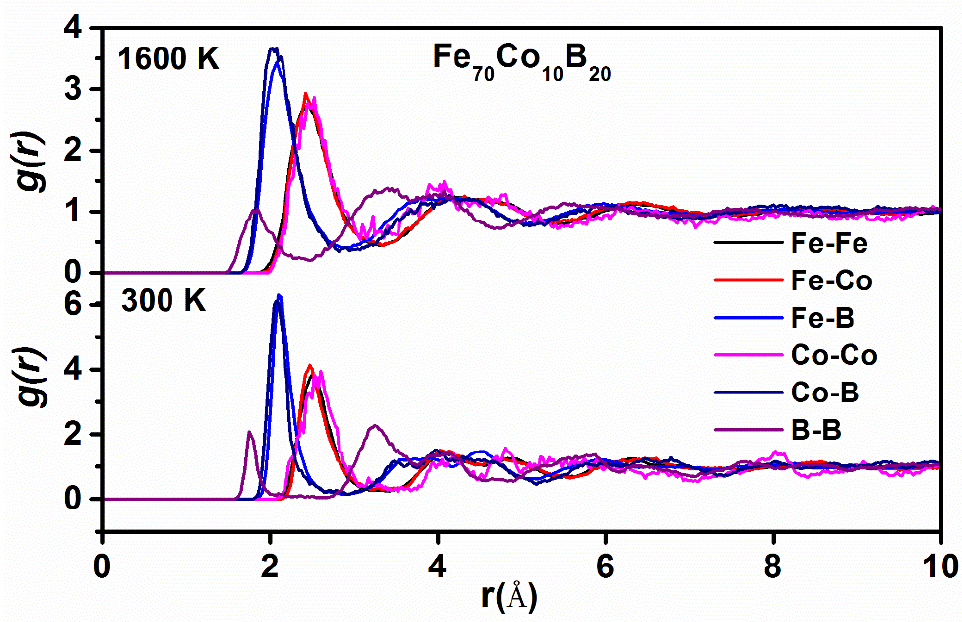
Figure 2. Partial pair distribution functions (PPDFs) at 1600 K and 300 K in Fe 70 Co 10 B 20 amorphous alloys.